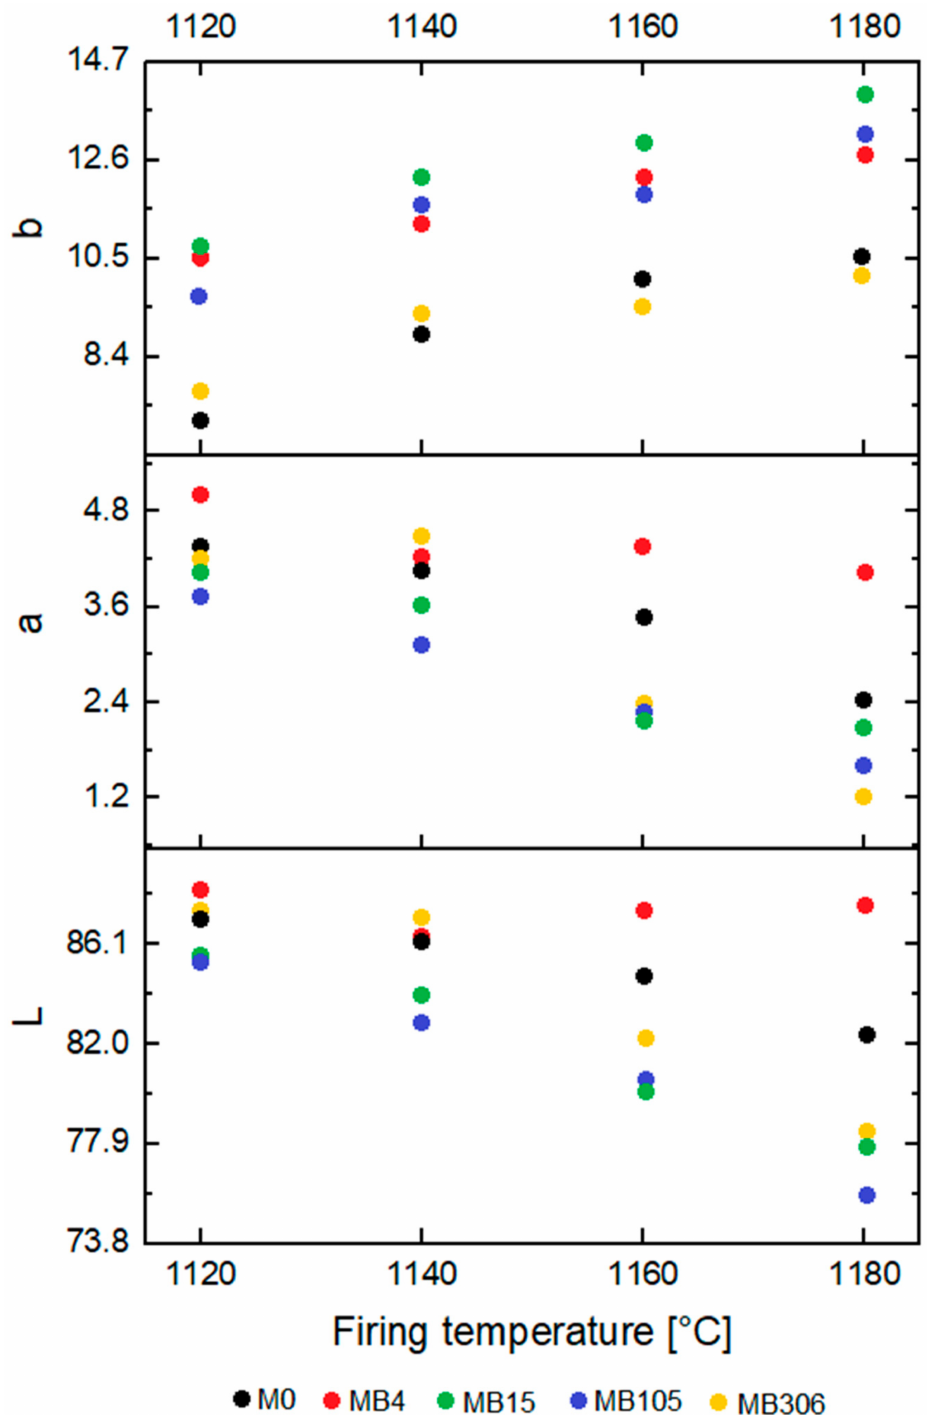
Figure 3. Color analysis of obtained ceramic materials: L, a and b color indicators for materials fired at: 1120, 1140, 1160 and 1180 ◦